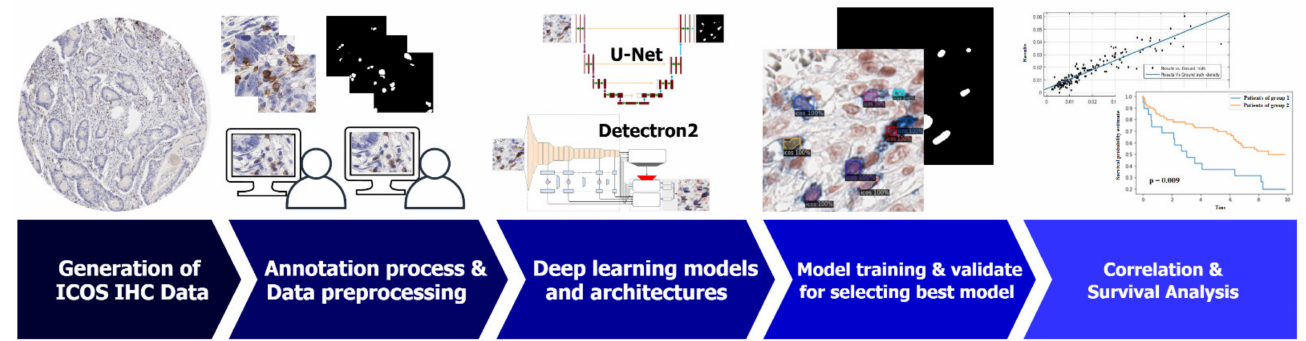
Figure 1. The step-by-step workflow: ICOS IHC data collection and annotated by expert pathologists; annotated data pre-processing for deep learning models; deep learning model selection and training; evaluating and selecting the best model; post-processing the best model outcomes and using them for ICOS correlation and survival